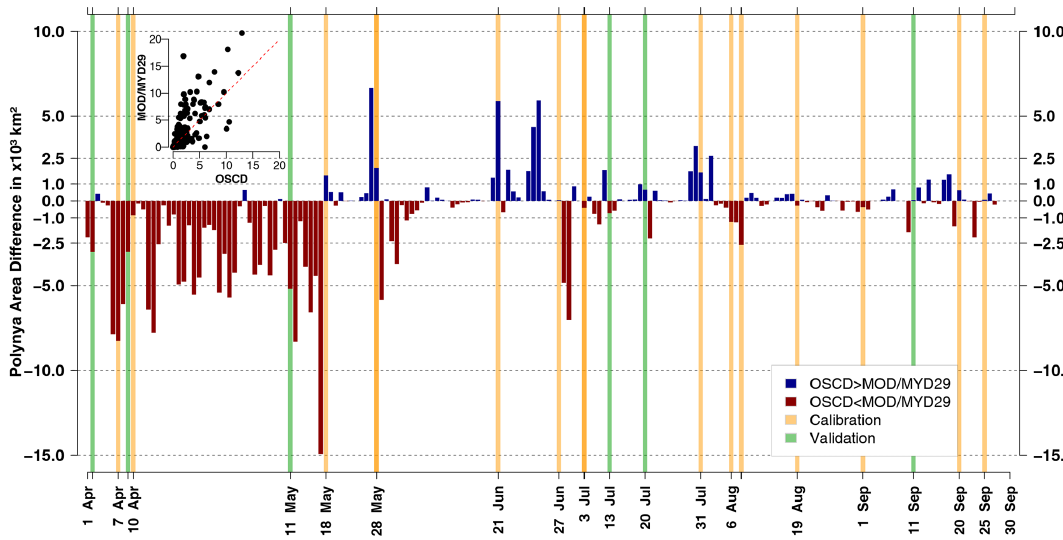
Figure 6. Daily polynya area difference in 10 3 km 2 using swath-wise pixel averages featuring a thin-ice thickness (TIT) ≤ 0.2m between OSCD and MOD/MYD29. Difference is calculated by subtracting MOD/MYD29 from OSCD; results with OSCD ≥ MOD/MYD29 are shown in blue; results with OSCD < MOD/MYD29 are shown in red. Orange vertical bars highlight days with S1-A/B swath coverage used for calibration or training of the OSCD algorithm. Green vertical bars show additional S1-A/B swaths used for validation between products (Figs. 4 and 5). The top-left corner features a scatterplot of the daily polynya with MOD/MYD29 to OSCD. Additional information about the S1-A/B swaths is provided in Table